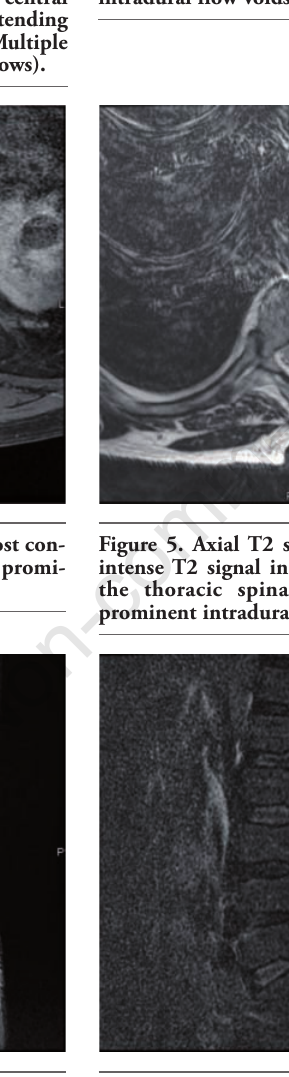
Figure 8. STIR sequence of the lumbar spine shows abnormality throughout the conus medularis with sparing of the periphery (arrows).